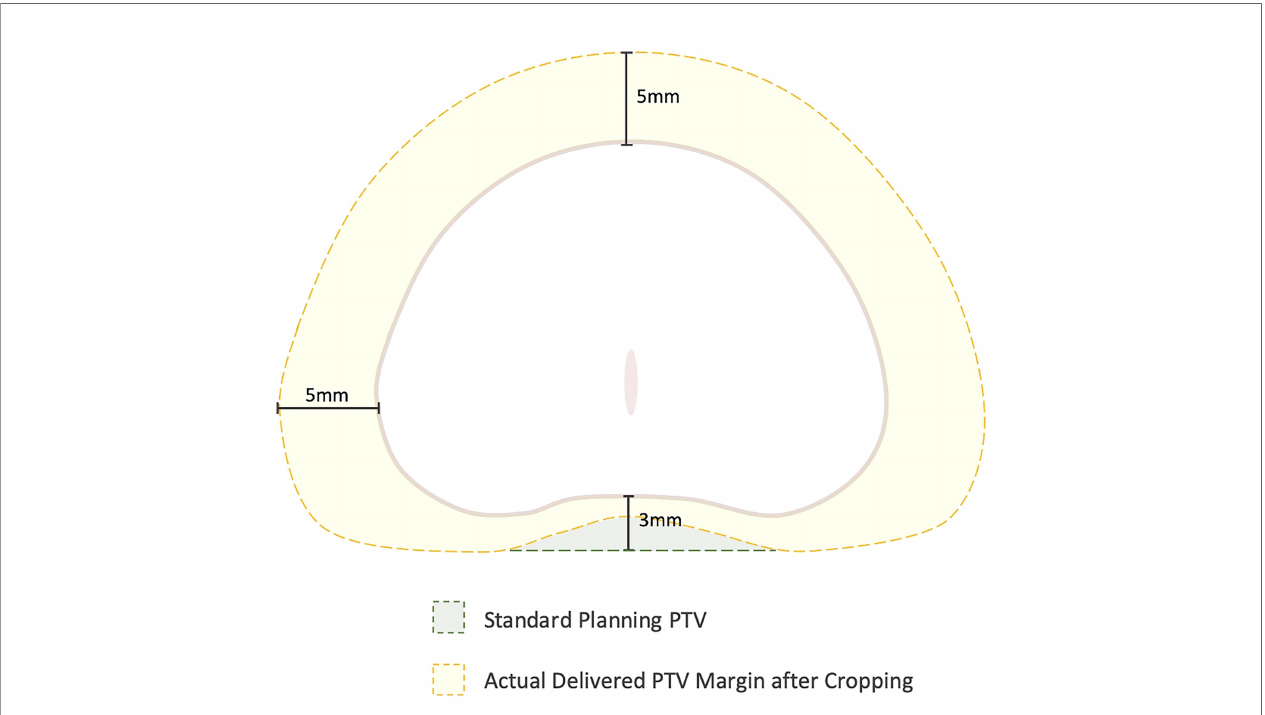
FIGURE 1 | Cropping of the Planning Target Volume (PTV) secondary to stringent rectal dose constraints. In general, the PTV is formed by expanding the prostate volume 3 mm posteriorly and 5 mm in all other dimensions. However, to achieve rectal dose constraints, the posterior margin is commonly cropped out of the rectum leading to a “ true ” posterior margin on such plans closer to 1-2